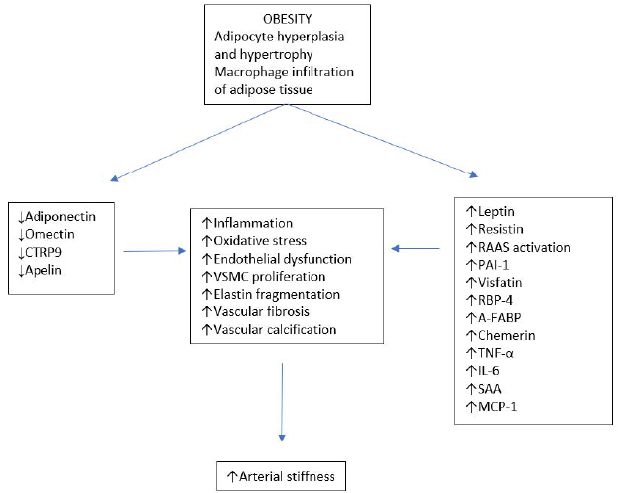
Figure 1. Obesity-induced adipokines’ modifications and arterial stiffness. Abbreviations: VSMC, vascular smooth muscle cell; RAAS, renin–angiotensin–aldosterone system; PAI-1, plasminogen activator inhibitor-1; RBP-4, retinol binding protein-4; A-FABP, adipocyte-fatty acid binding protein; TNF-α, tumor necrosis factor-α; IL-6, interleukin-6; SAA, serum amyloid A; MCP-1 monocyte chemoattractant protein-1.